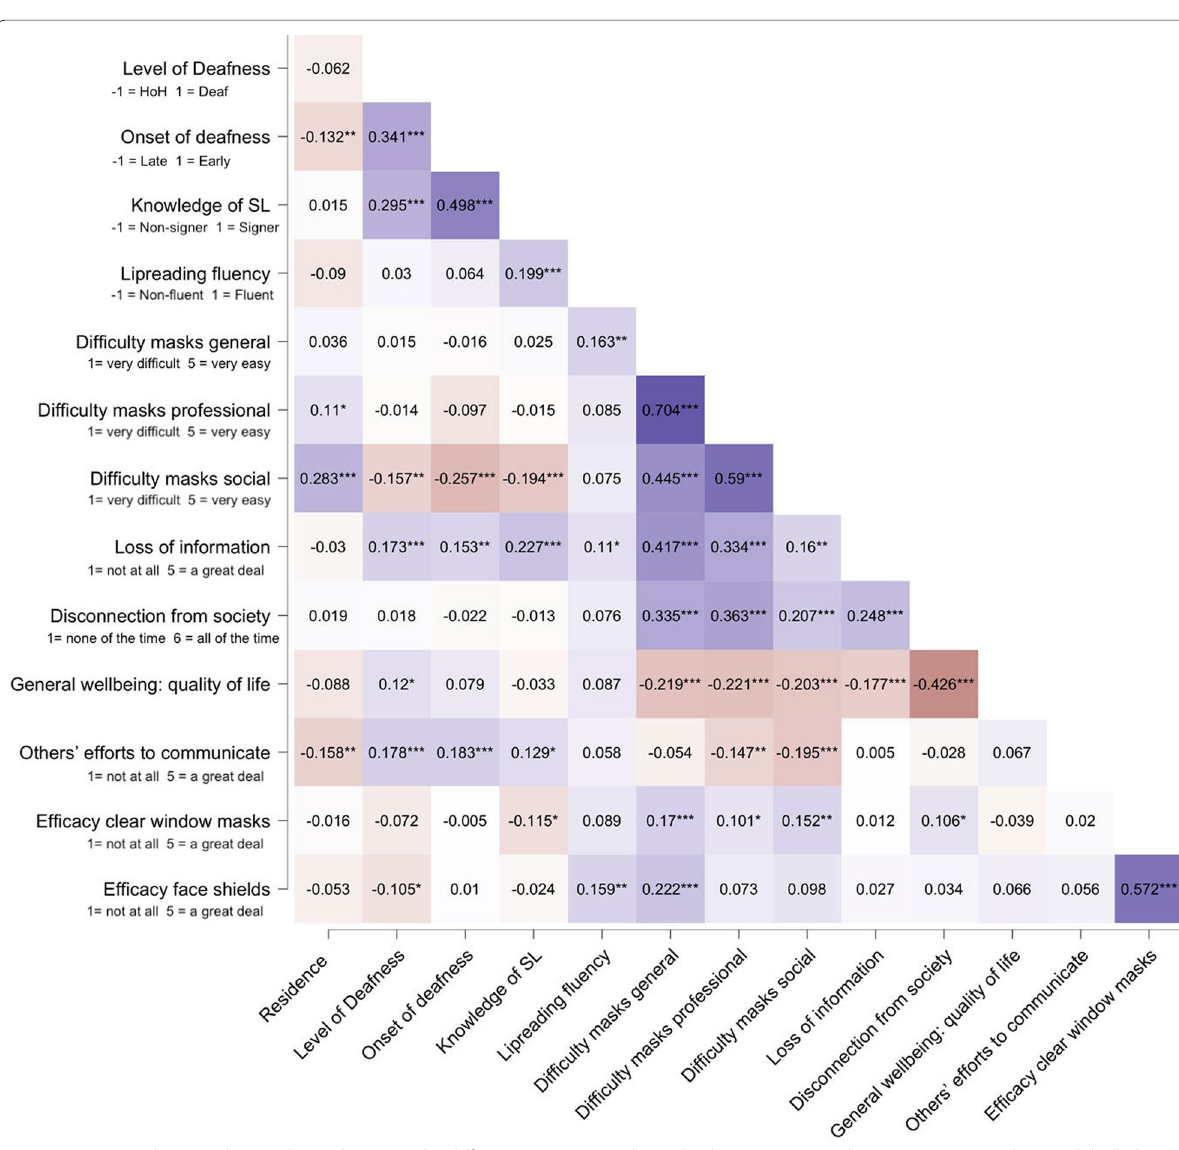
Fig. 2 Heatmap showing the correlation between the different measures. Darker red colours represent a larger negative correlation while darker purple show a larger positive